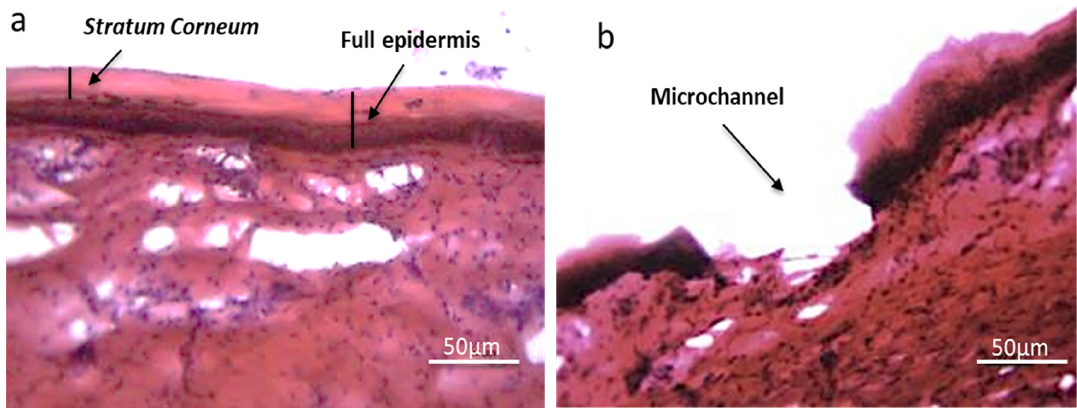
Figure 2. Optical microscopy images of porcine skin treated with microstructure ( b ), compared to untreated porcine skin ( a ).